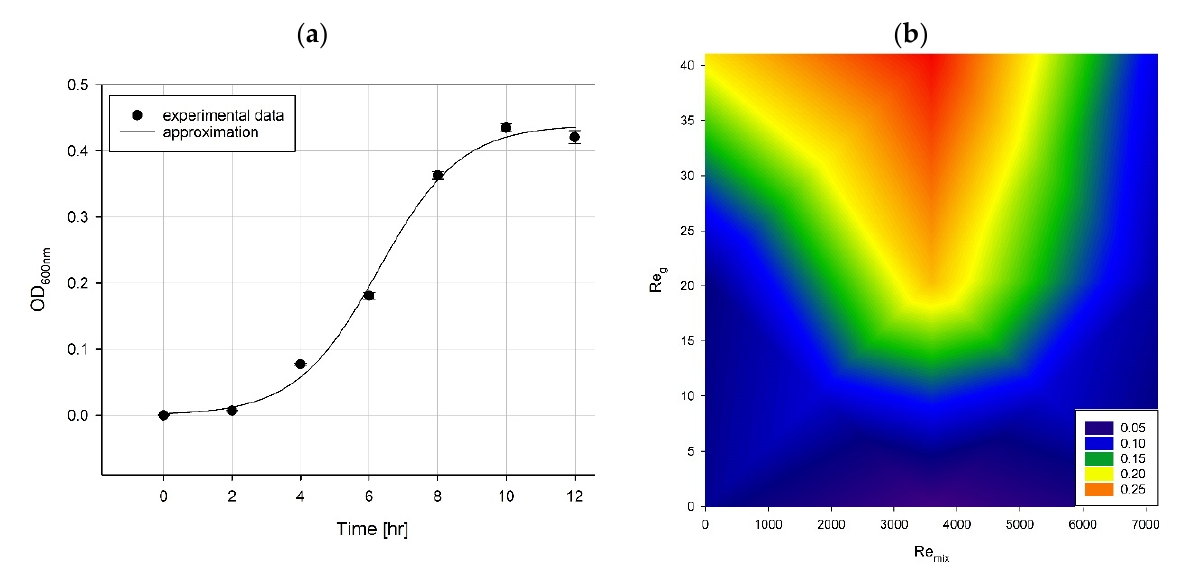
Figure 4. Typical growth curve of the studied bacterial cells ( a ) and bacterial growth factors for the studied process conditions ( b ).